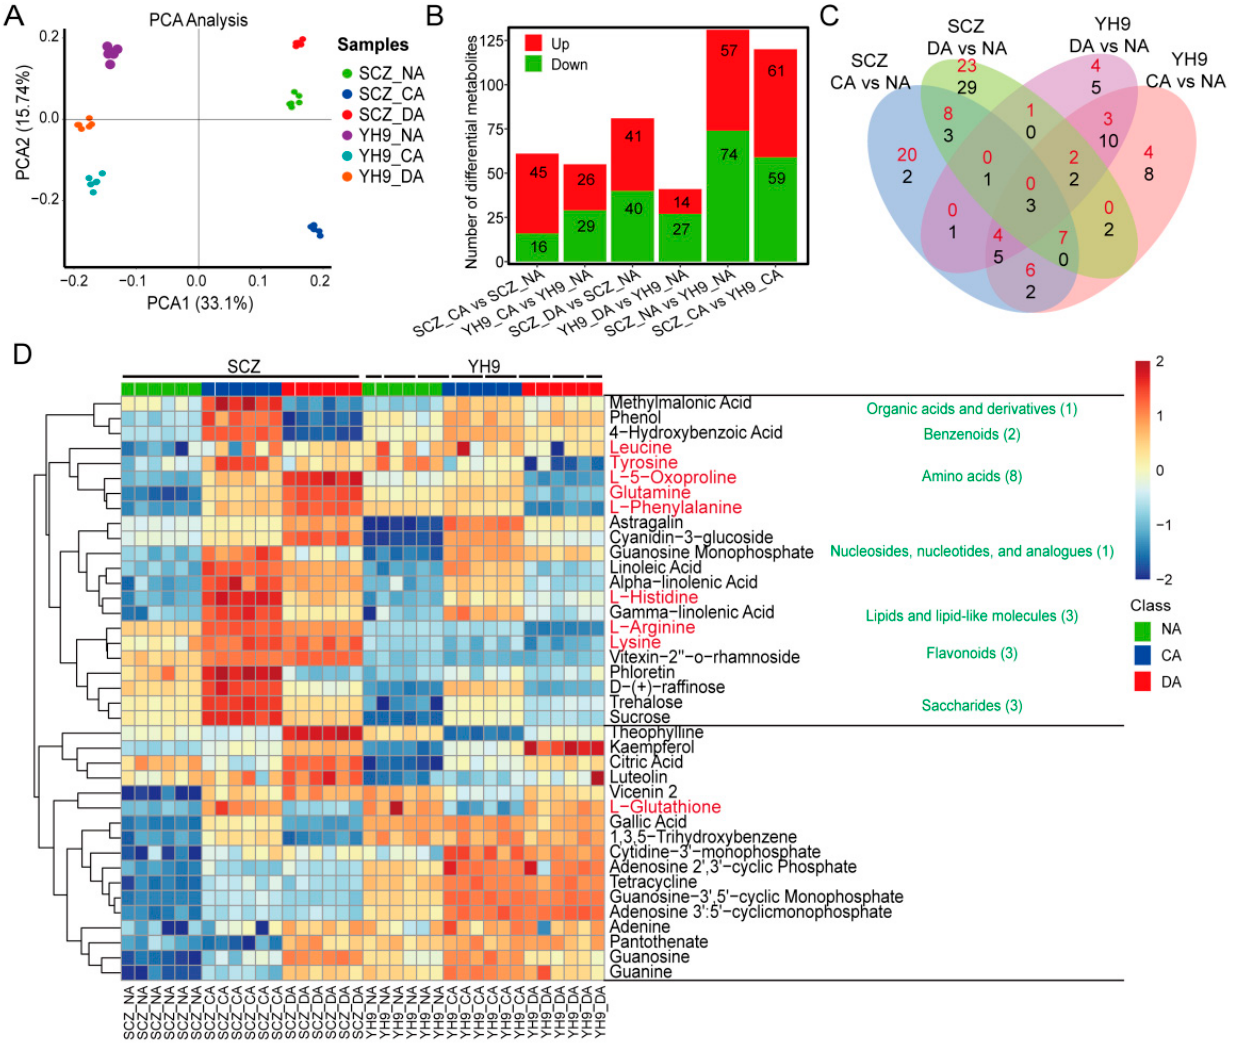
Figure 2. Metabolome analysis of SCZ and YH9 in response to cold acclimation. ( A ) PCA (Principal component analysis) clustering based on metabolome data. ( B ) Number of differentially expressed metabolites in two tea varieties. ( C ) Venn diagrams of differential accumulated metabolites between SCZ and YH9 during cold acclimation (CA and DA). Red represents up-regulation and black repre- sents down-regulation. ( D ) Heatmap of differential accumulated metabolites between SCZ and YH9 during cold acclimation.